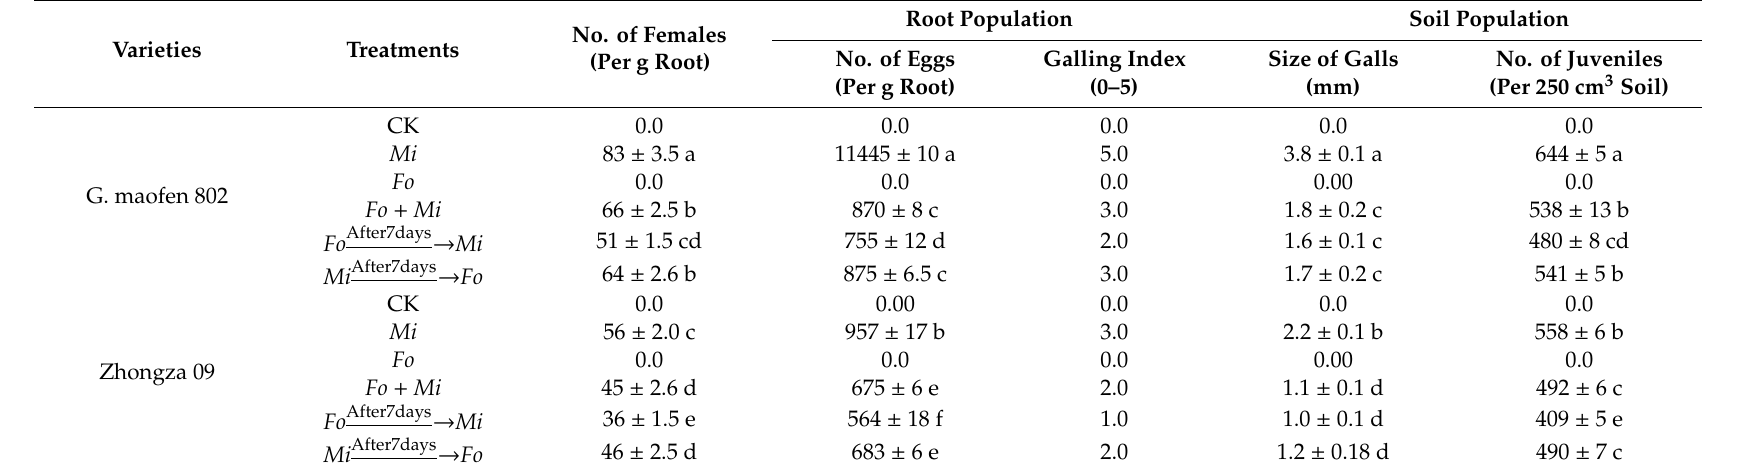
Table 3. E ff ects of Fusarium oxysporum and Meloidogyne incognita alone and in combination on two tomato roots of G. maofen 802 and Zhongza 09 cultivars under greenhouse conditions after 35